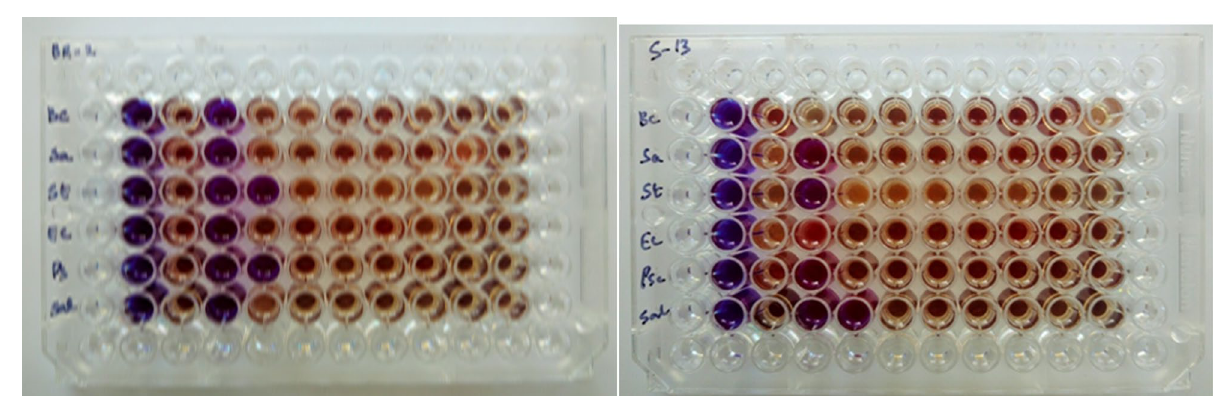
Figure 3. Pectin sample of BR- 2 and S-13 micro titer